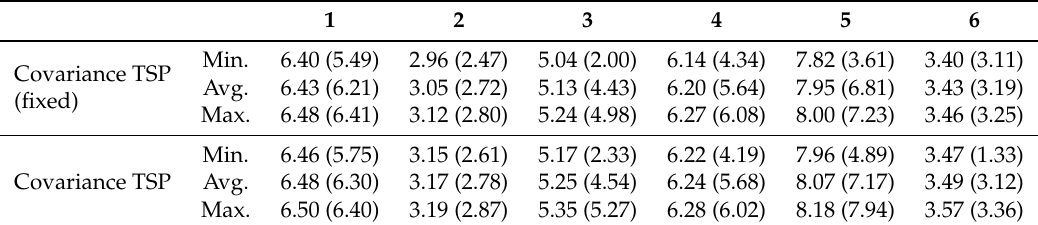
Table 1. The reduction of the trace sum of the landmarks registered in the SLAM state at the time when revisiting was planned and started.